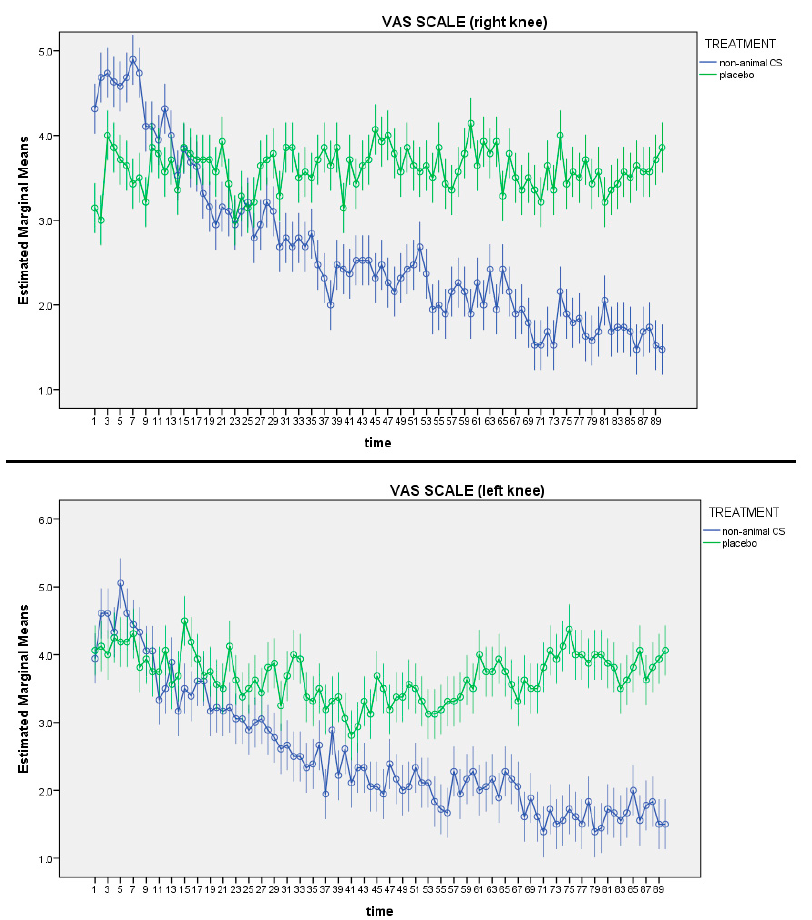
Figure 1. Visual analogue scale (VAS) of left and right knee. In both knees the VAS differences between groups are statistically significant over time ( p < 0.05).